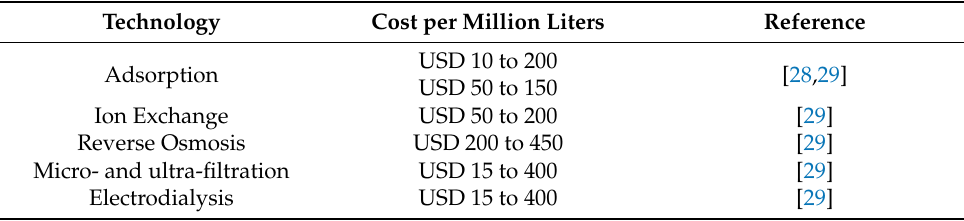
Table A1. Costs of wastewater treatment technologies.